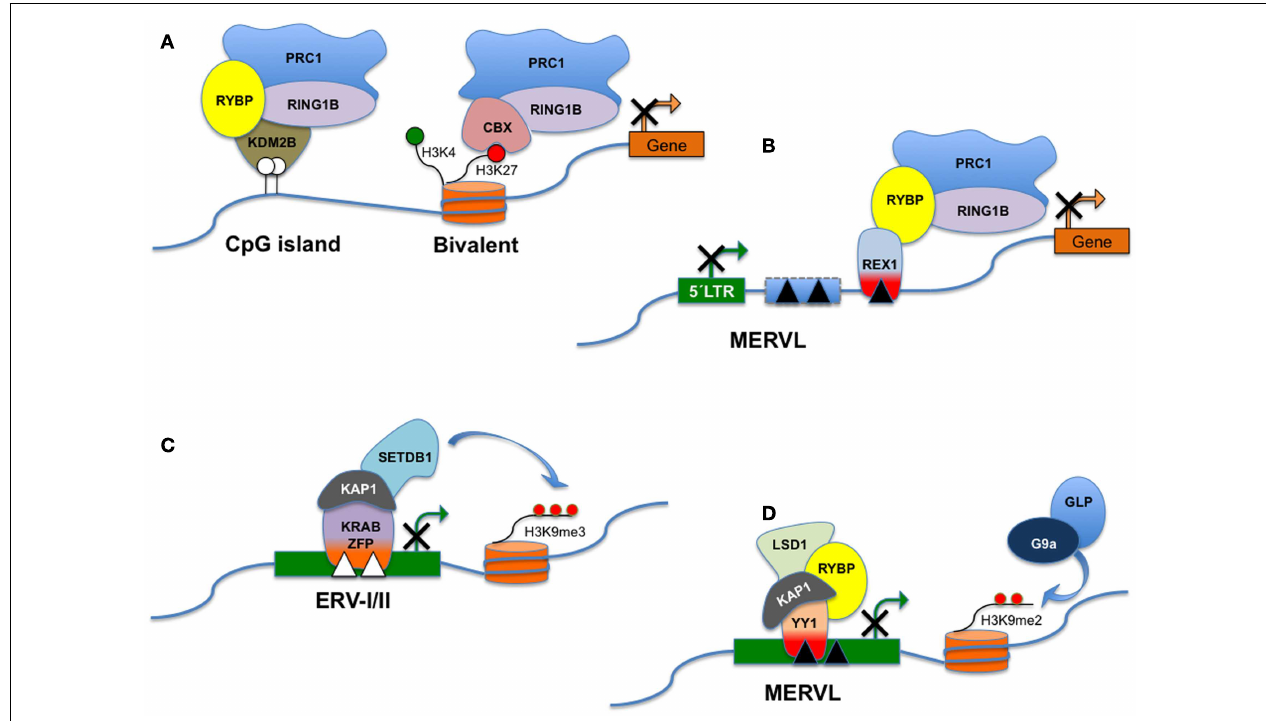
FIGURE 3 | RYBP and distinct PRC1-like complexes . Polycomb Group genes (PcG) assemble into multiprotein complexes and, depending on the subunit composition, the complexes are recruited to different types of target sites. PRC1 (Polycomb repressive complex 1) is a canonical complex composed of either RING1A/or RING1B, MPH1/2/3, CBX2/7/8, and one of the Polycomb group RING fingers proteins (PCGF2–5) and is referred to here as CBX-PRC1 (A) . CBX-PRC1 mediates H3K27me3-dependent silencing of bivalent promoters. PcG-regulated promoters devoid